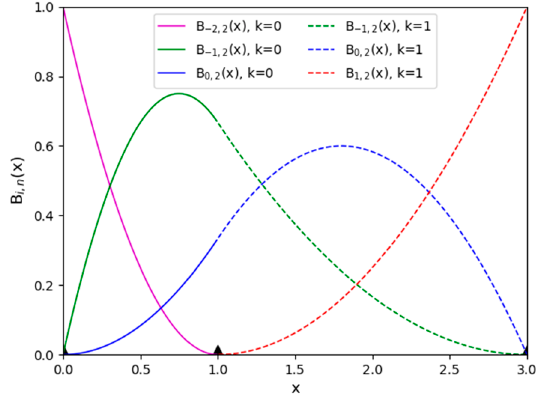
x = , result- and 3 = 1 and x = 0, x = 3, resulting k k 1 k 2 0 0